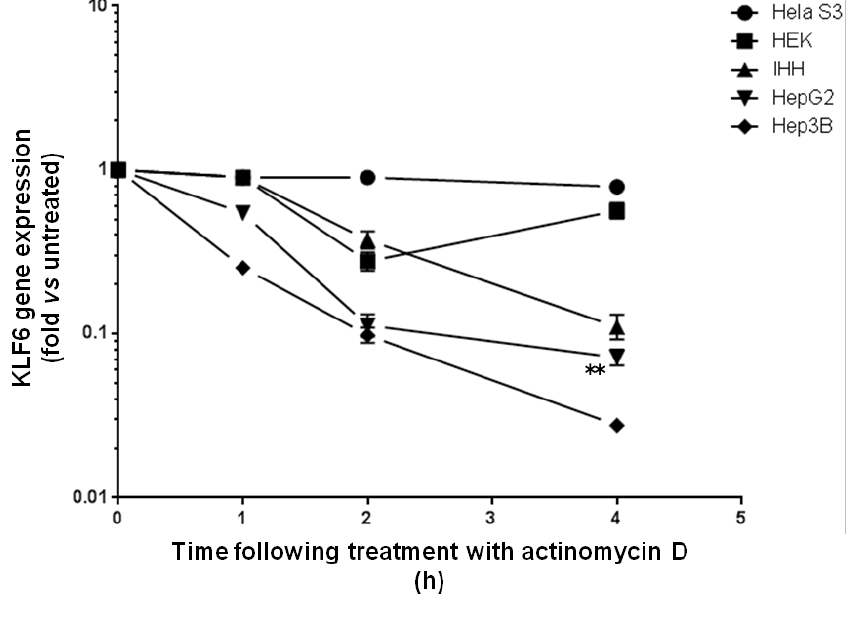
Figure 2. Determination of KLF6 mRNA half life in hepatic and non-hepatic cell lines. Hela, HEK, IHH, HepG2 and Hep3B cells were treated with Actiomycin D as described in Experimental Section. KLF6 mRNA expression was quantified by qRT-PCR at the times indicated. Results are mean ± S.D. of three independent experiments. **: p <